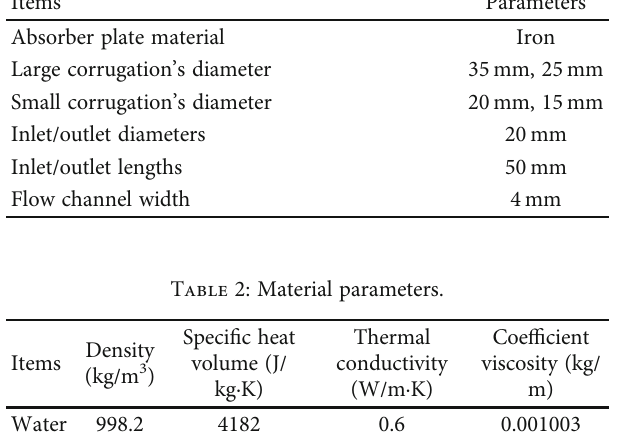
Figure 1: Schematic of the thermal absorber (a) and the associated PV/T prototypes (b). Table 1: Relevant parameters of the heat absorber plate core. Items